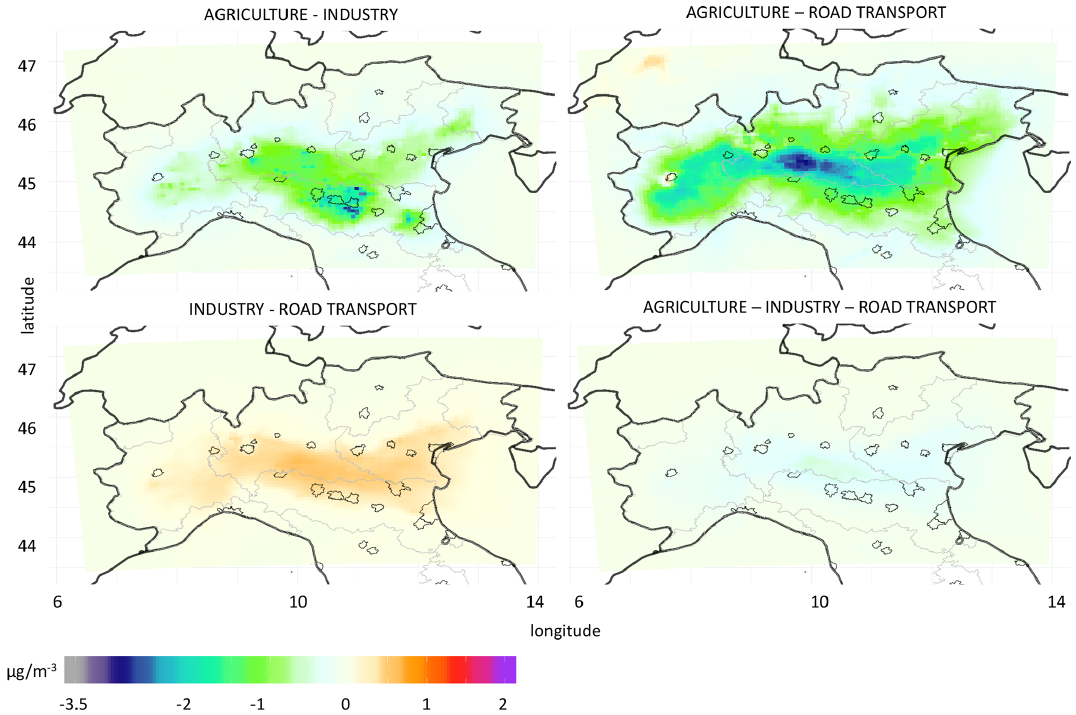
Figure 5. Map of the binary and ternary interaction terms of the PM 10 factor decomposition for AGR, IND and TRA in the CAMx BF 100%